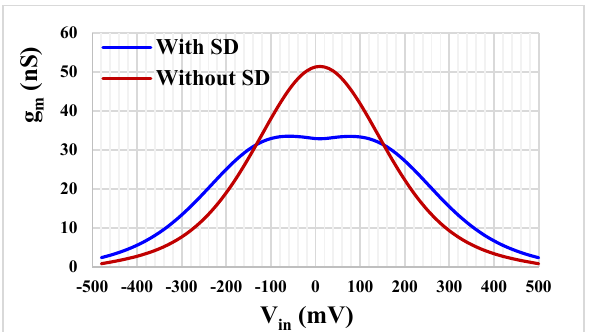
Figure 7. The transconductance characteristics of the TA with and without SD technique.